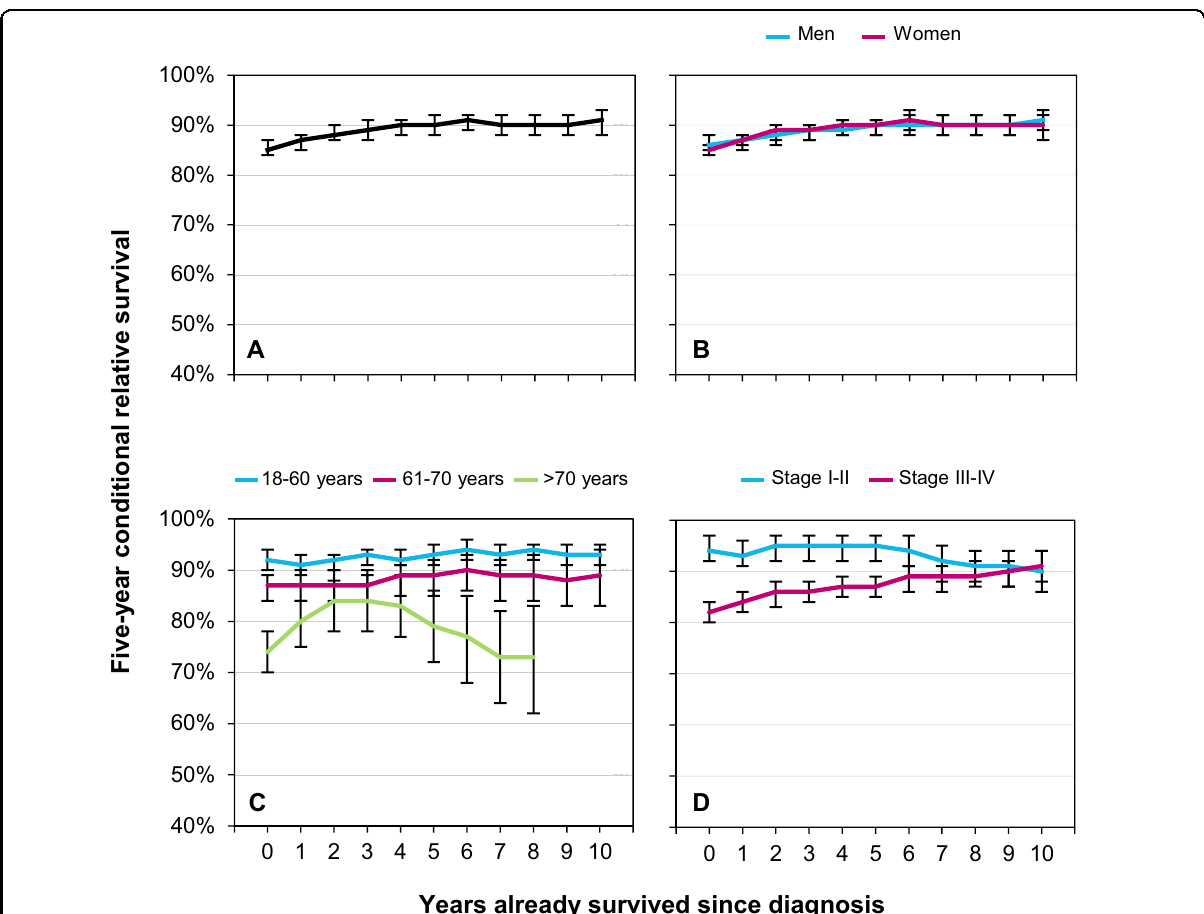
Fig. 1 Five-year conditional relative survival (CRS) up to ten years post-diagnosis among adult patients diagnosed with follicular lymphoma in the Netherlands, 2000 – 2017. The 5-year CRS is presented for the overall cohort ( A ) and according to sex ( B ), age at diagnosis ( C ), and disease stage at diagnosis ( D ). The error bars for the point estimates indicate 95% con fi dence intervals. The point estimates of CRS are considered reliable when the standard error (SE) is ≤ 5%. When the SE is above 5%, the CRS estimates are not